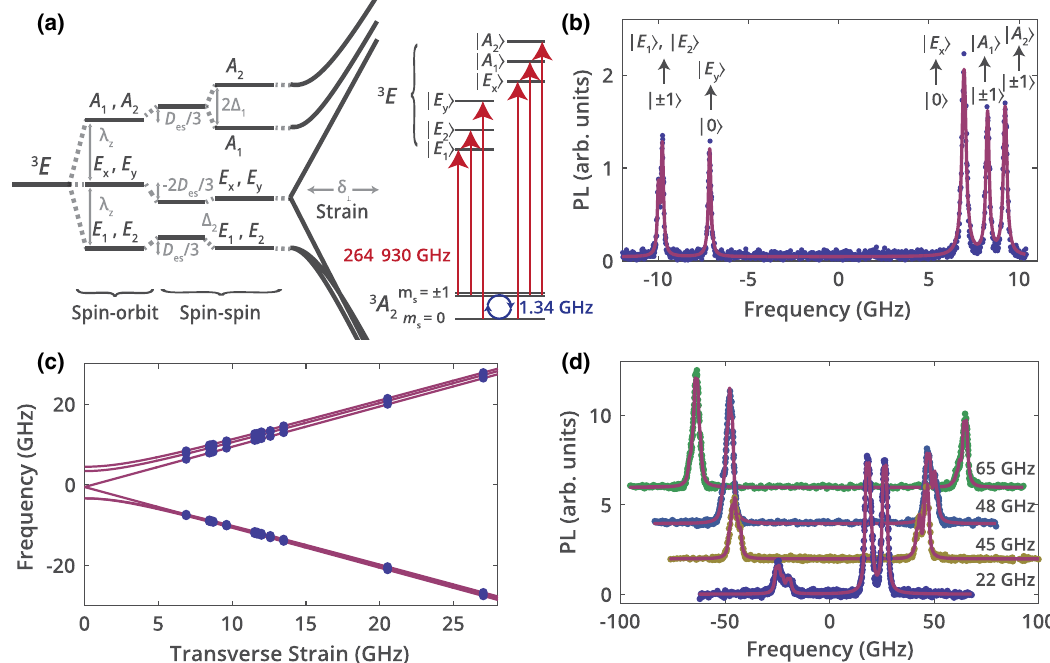
FIG. 2. Excited-state fine structure of 4H- and 3C-SiC divacancies. (a) Left: Level diagram of the 3 E excited state, showing the effect of axial spin-orbit coupling, the three spin-spin interactions, and transverse strain. Right: Diagram of optical transitions excited in a PLE measurement that are nominally spin-conserving at low strain, which are near 264 930 GHz for ( hh ) divacancies. Microwave driving near D ¼ 1 . 34 GHz is applied to produce a mixed time-averaged population in the ground state so that all six transitions can be observed. (b) Photoluminescence excitation measurements taken on a single 4H-SiC ( hh ) divacancy with a transverse strain of δ ⊥ ¼ 7 GHz at T ¼ 8 K under continuous microwave driving. (c) Individual resonances recorded at T ¼ 8 K on separate ( hh ) divacancies that experience different magnitudes of transverse strain. The solid lines are the Hamiltonian energies at the best fit value. (d) Photoluminescence excitation measurements taken T ¼ 8 K on single 3C-SiC divacancies that experience different transverse strains. The estimated magnitude of the transverse strain is labeled in units of GHz on each trace. The solid lines are fits to a sum of Lorentzians intended only as a guide to the eye since the larger linewidths make the number of spin-conserving and spin-nonconserving transitions that are visible